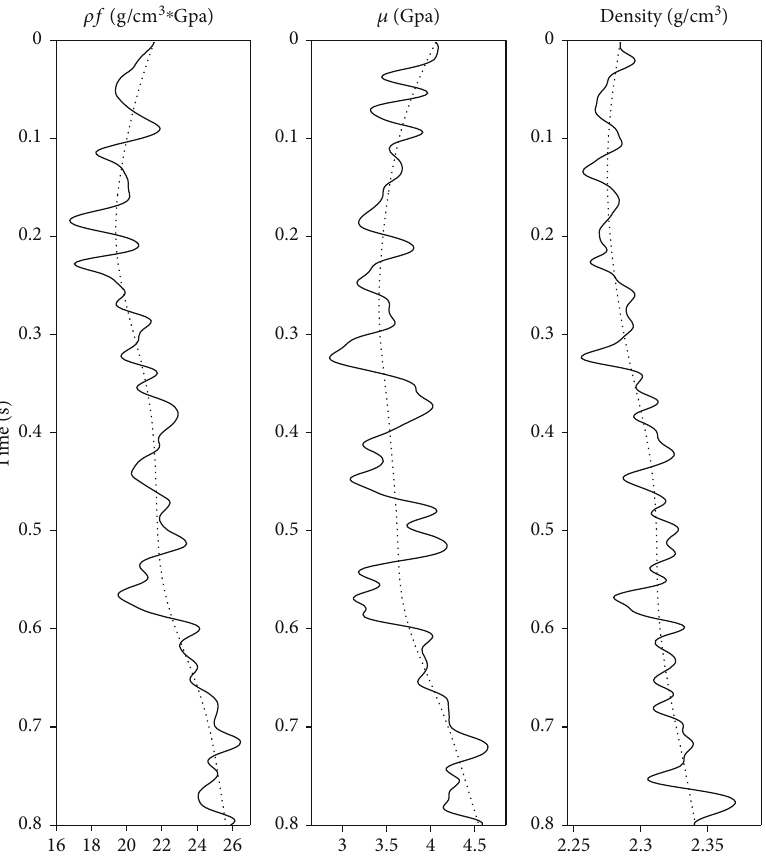
Figure 3: True model data (solid line) and initial model data (dashed line).